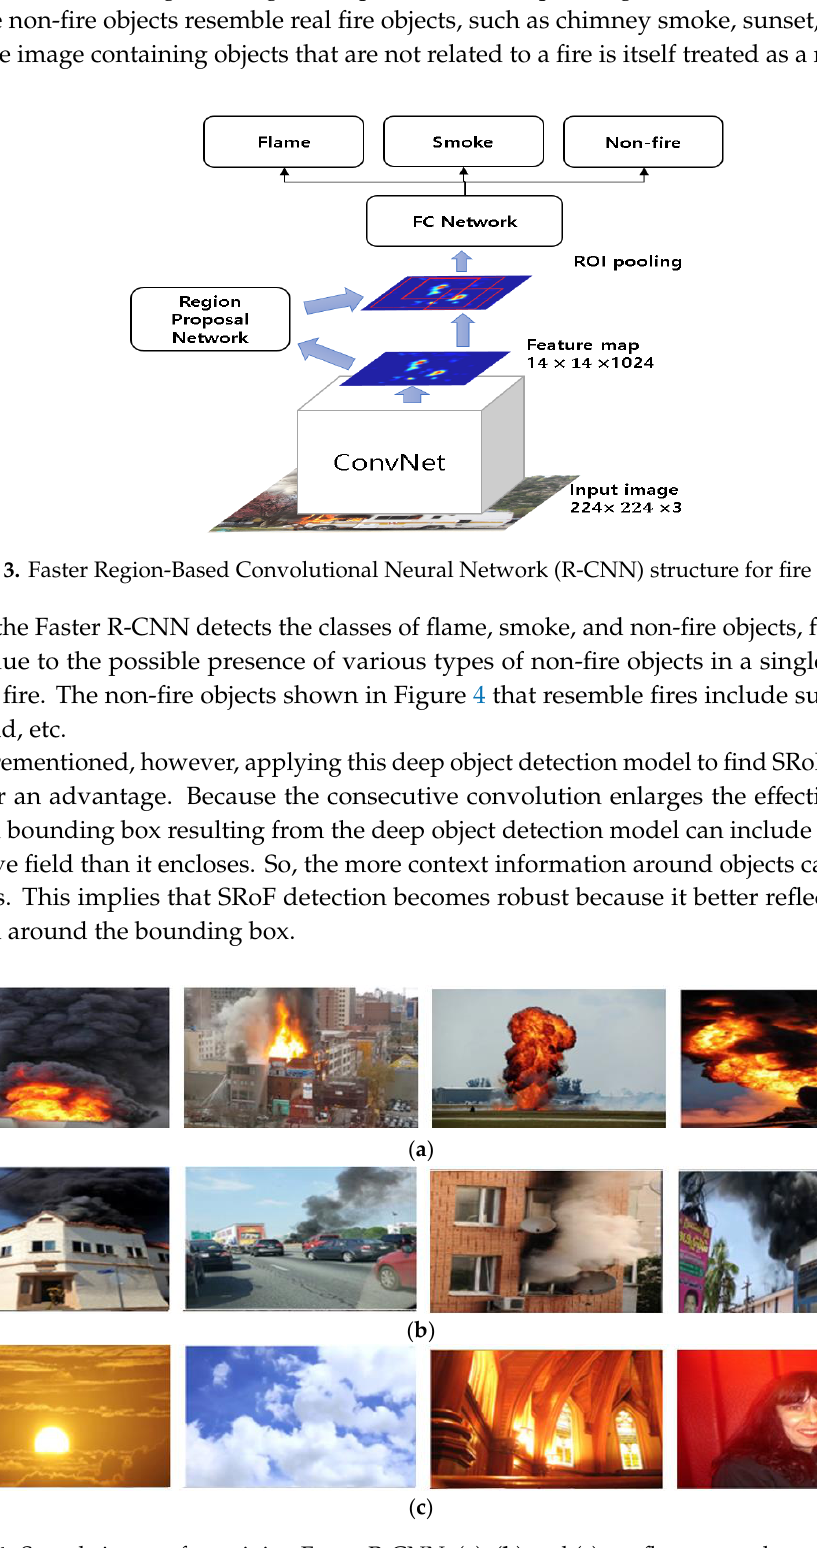
Figure 4. Sample images for training Faster R-CNN; ( a ), ( b ) and ( c ) are flames, smoke, and non-fire images, respectively.